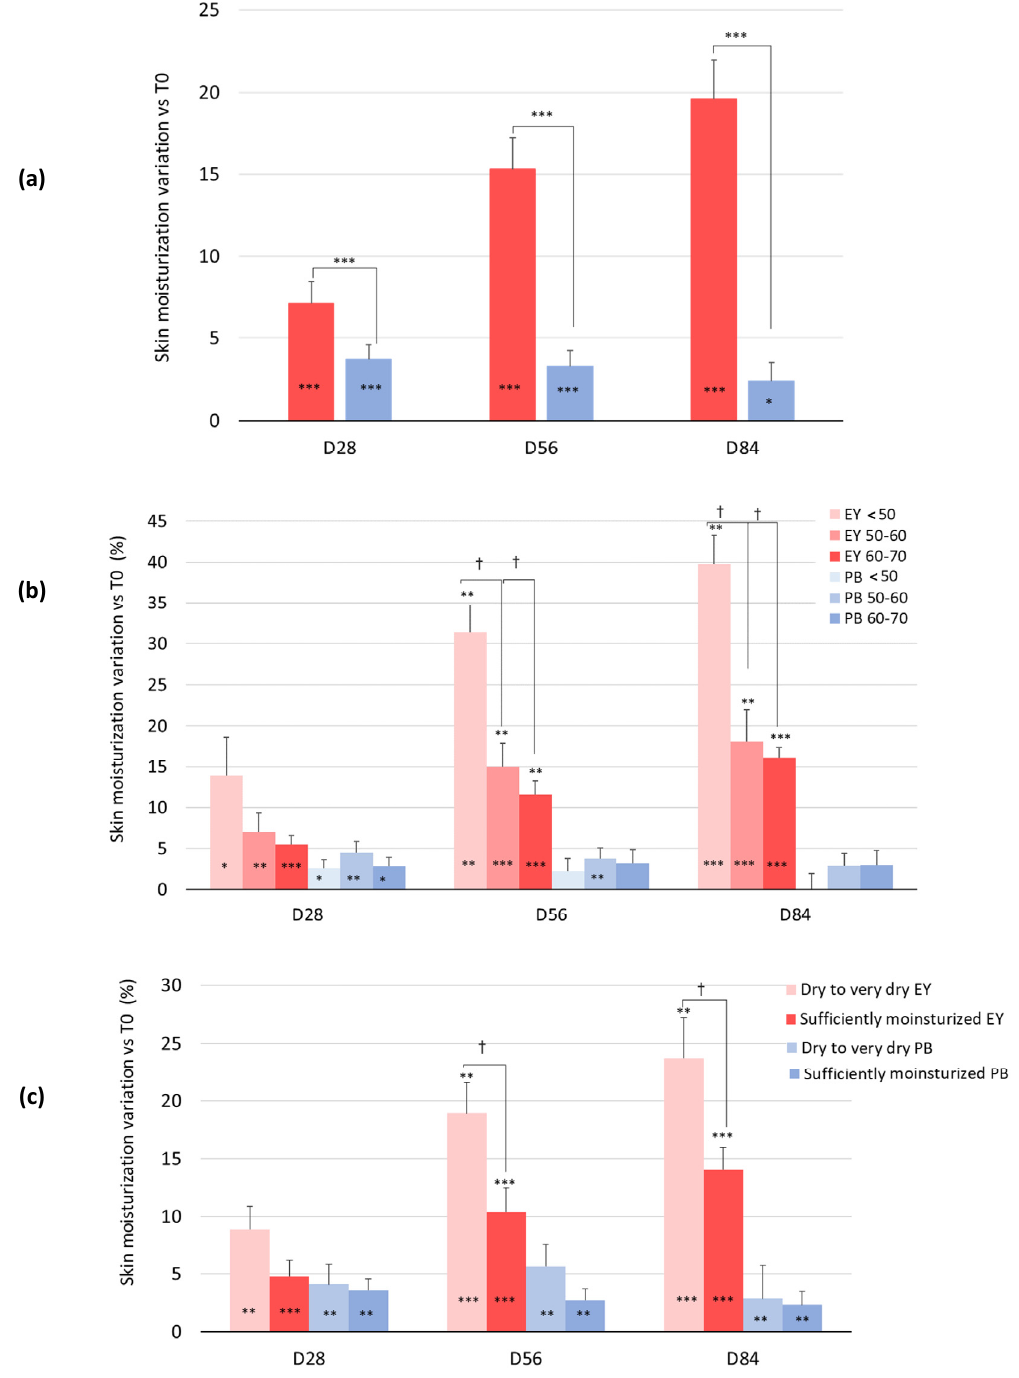
Figure 2. Change in facial skin hydration. ( a ) Skin hydration variation versus baseline after 28, 56, and 84 days in the EY treatment (red bars) and placebo (blue bars) groups. Changes in the skin hydration versus baseline in ( b ) age-related (<50; 50–60 and 60–70 years old) and ( c ) skin type-related (dry skin type and sufficiently hydrated skin type) subgroups in the EY treatment (red bars) and placebo groups (blue bars). * p < 0.05, ** p < 0.01, and *** p < 0.001. Inter-subgroup statistical analysis is reported with † upon the bars of the histograms as follows: † p < 0.05.